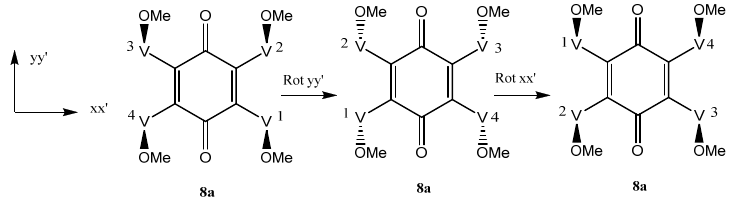
Scheme 4. Sequence of events leading to tetra-adducts.